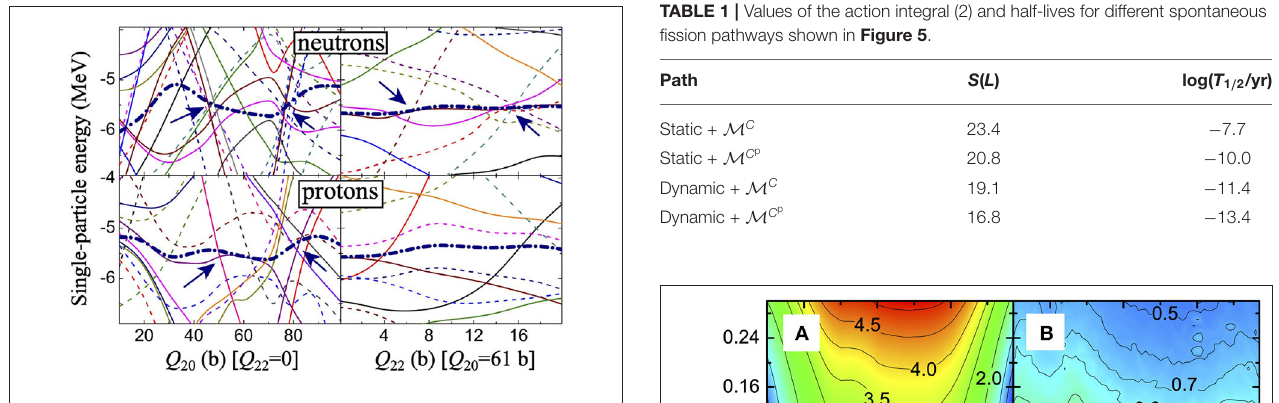
0) and Q 22 (right, at =